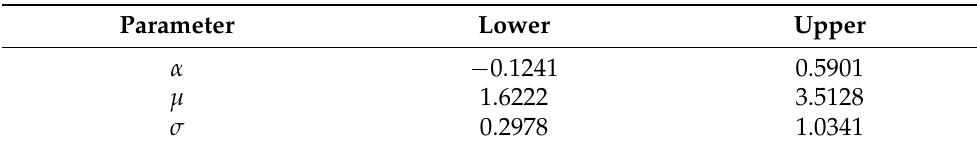
Table 12. The 95% asymptotic confidence intervals of the GDUSLN parameters based on bladder cancer dataset.